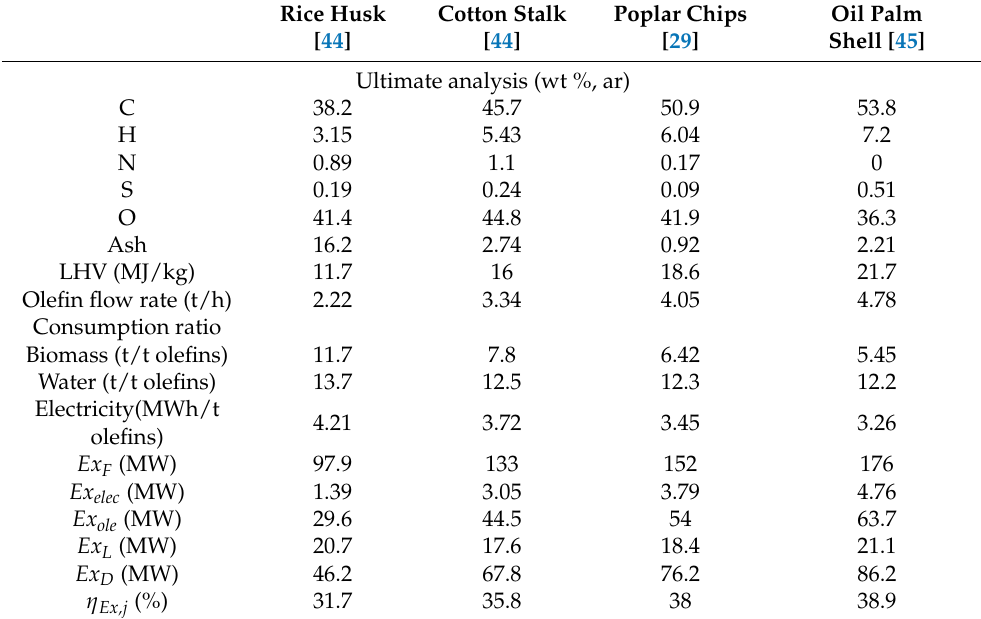
Table 7. Effect of feedstock type on overall exergy performance of biomass-olefin system. Rice